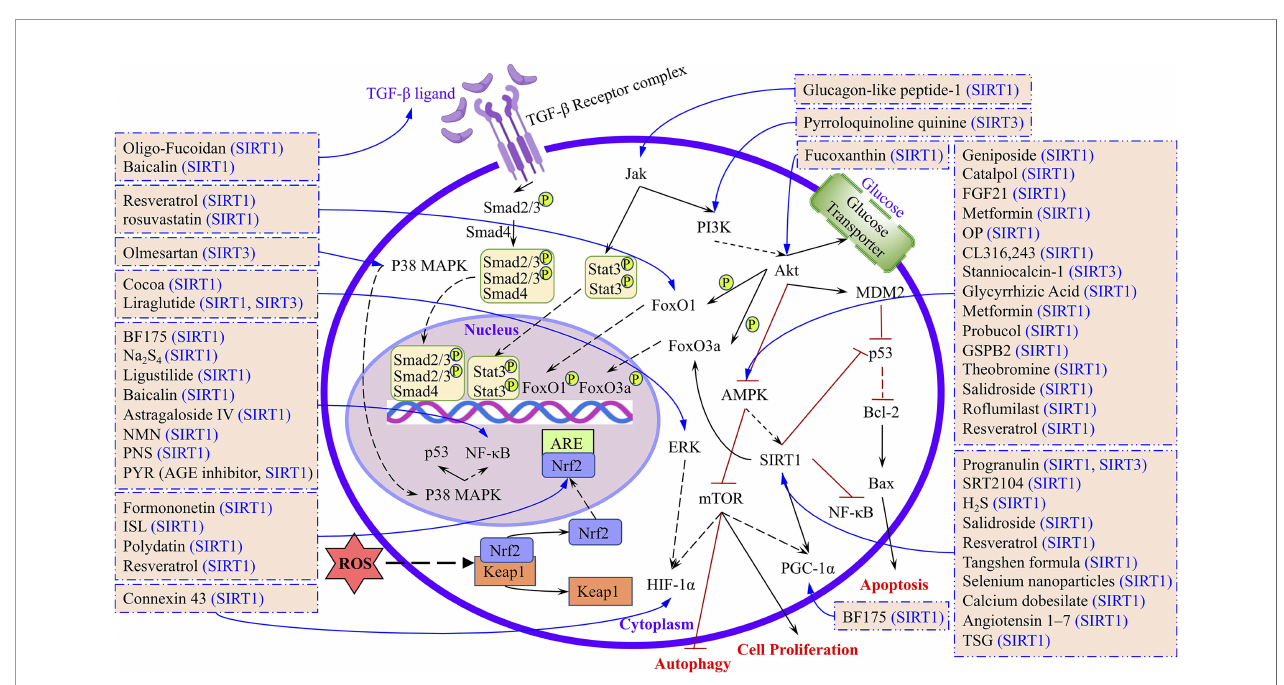
FIGURE 3 | The targets and signaling pathways of different drugs or compounds regulated by sirtuins were